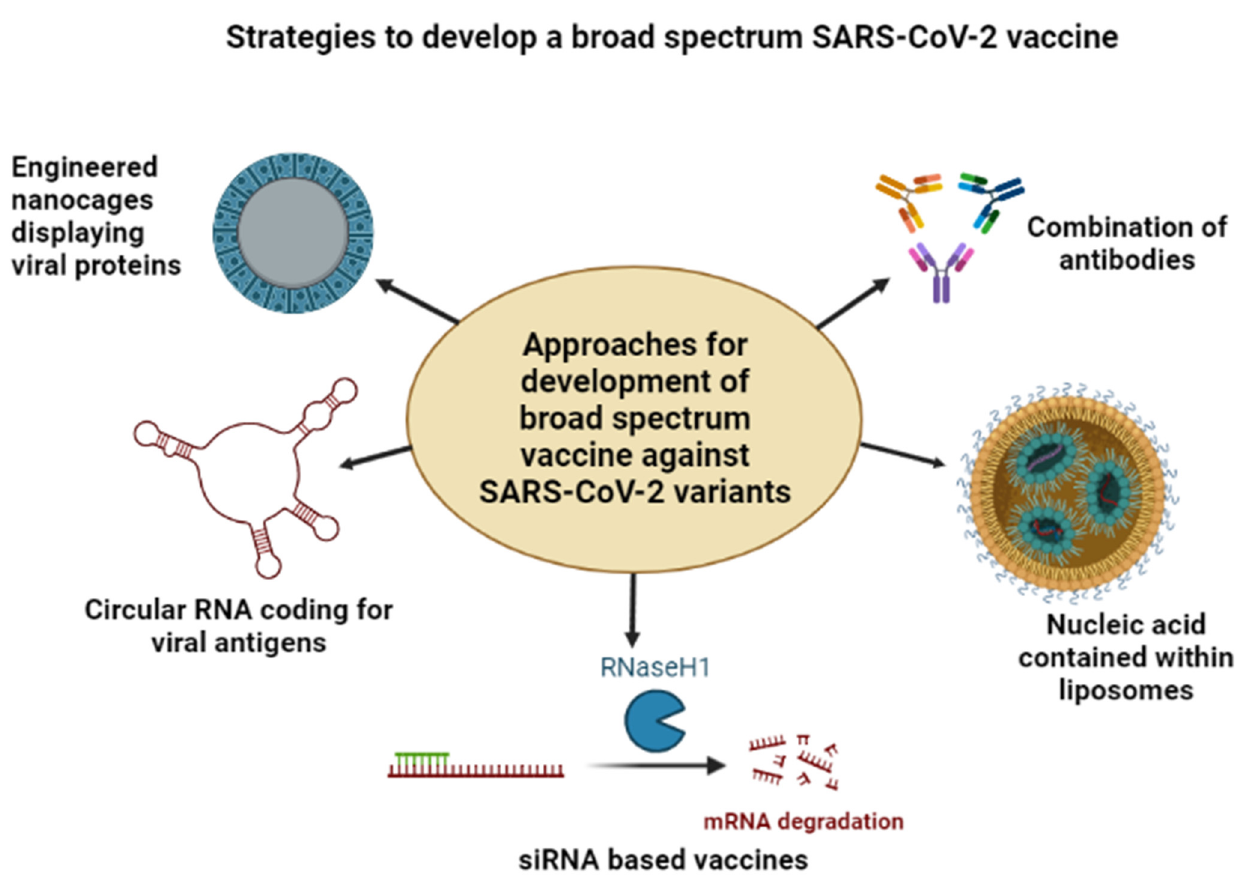
Figure 2. Strategies illustrating the methodology for the development of broad-spectrum SARS- CoV2 vaccine.